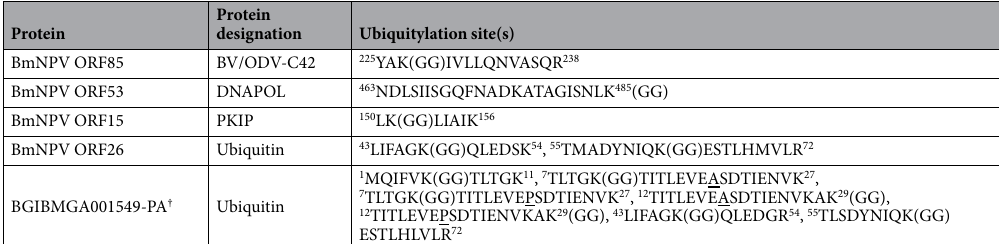
Table 3. Ubiquitylated proteins and their identified ubiquitylation site(s). † The host gene BGIBMGA001549-TA encodes a pre-protein containing tandem head-to-tail repeats of the monomeric ubiquitin sequence. This pre-protein is then processed by de-ubiquitinating enzymes to produce two host ubiquitin monomers. The difference in the sequences of the two monomers is that one contains an alanine at amino acid position 19 (Ala 19 ), and the other contains Pro 19 at the same position. The Ala 19 and Pro 19 were